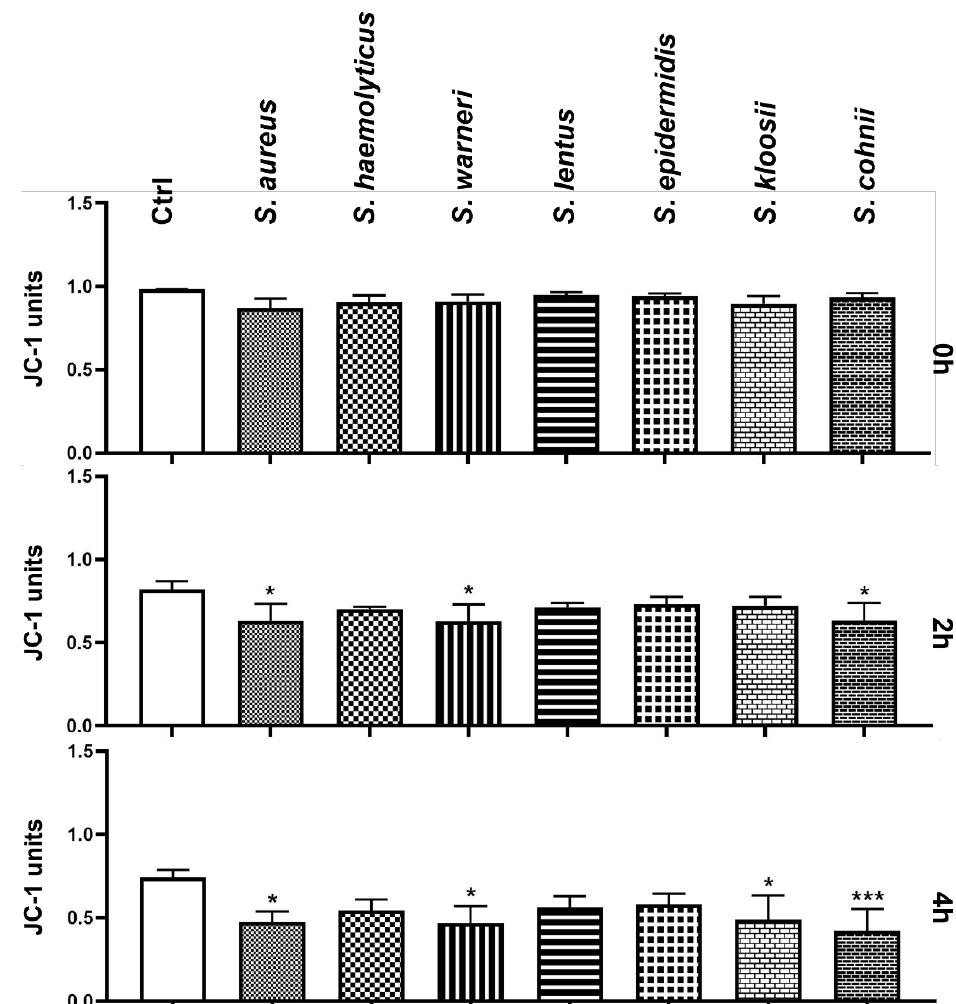
Figure 3. Changes in sperm mitochondrial membrane potential during the 4 h bacteria/sperm co-incubation in vitro at 37 °C. Each group treated with Staphylococcus species was compared with the Ctrl group with no added bacteria. Each bar represents the mean ratio of JC-polymers and JC-monomers ± S.E.M. Five individual experiments were performed to obtain these data. The level of statistical significance was set at * p < 0.05; *** p < 0.001.